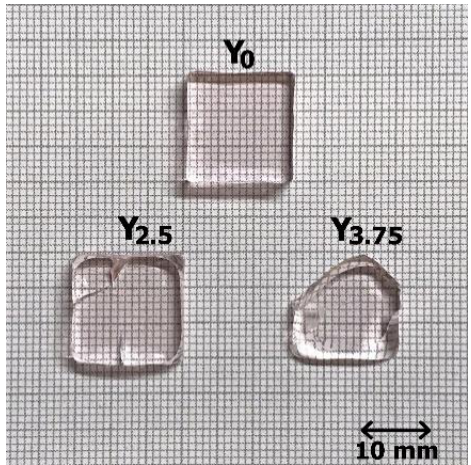
Figure 1. The photo of the investigated Er, Yb:phosphate glass samples. The visible cracks occurred during the polishing of the glasses.